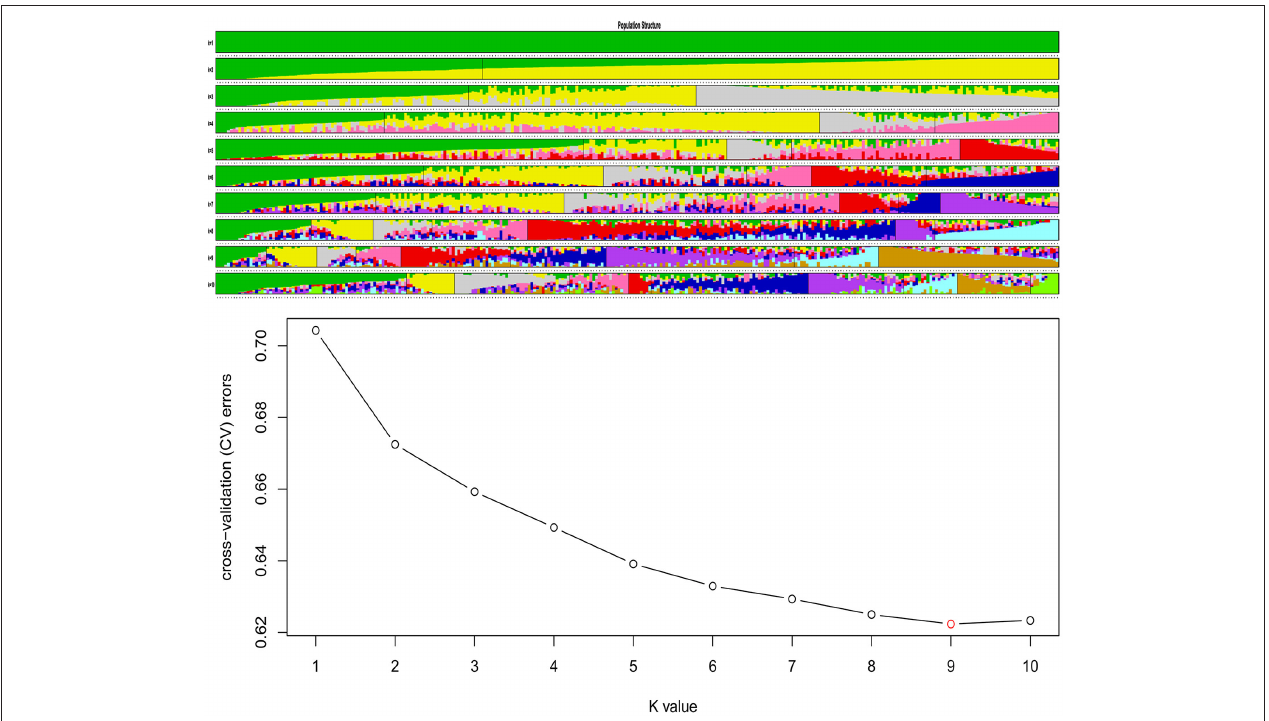
FIGURE 3 | Population structure of 300 accessions of B. napus. The accessions were divided into nine subgroups (there was minimum K -value when K = 9), within each subgroup, the accessions were ordered according to the genetic component, and each line gives the sub-group value, each accession shown as a vertical line partitioned into K colored components represents inferred membership in K genetic